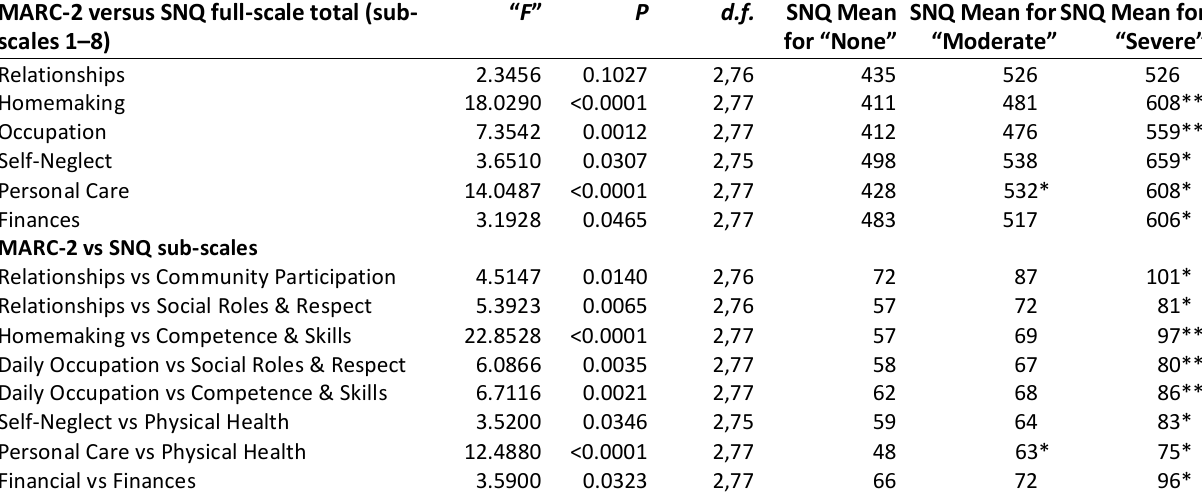
Table 7. MARC-2 problem severity rating scores versus SNQ full-scale total and sub-scale scores. MARC-2 versus SNQ full-scale total